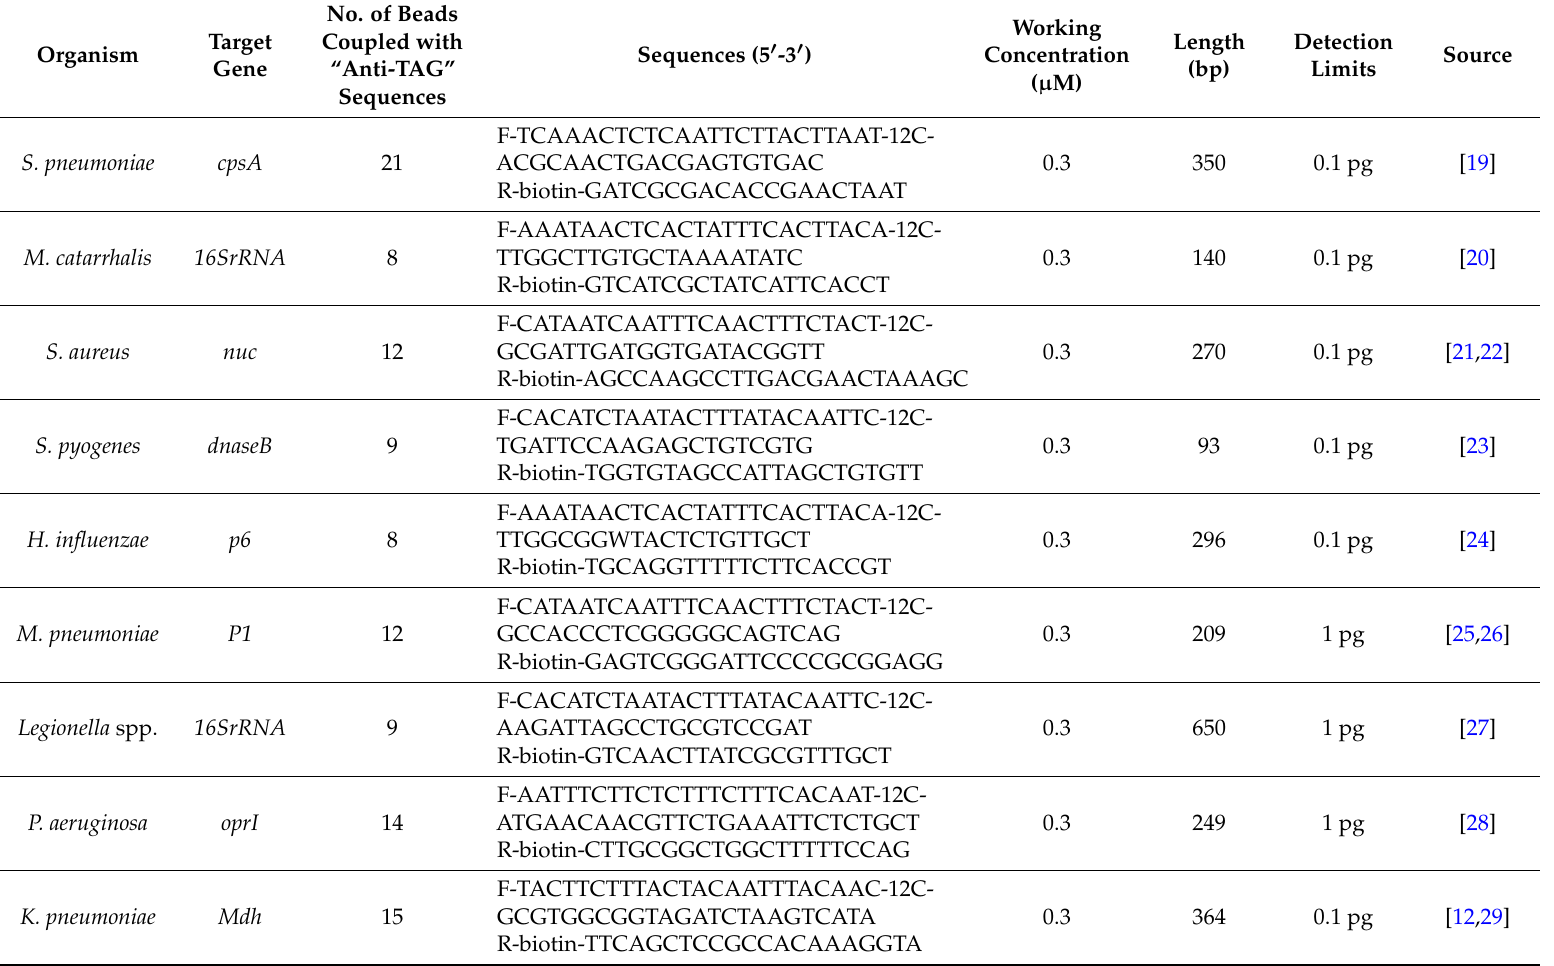
Table 2. List of target bacteria, genes, primers, and their amplicon